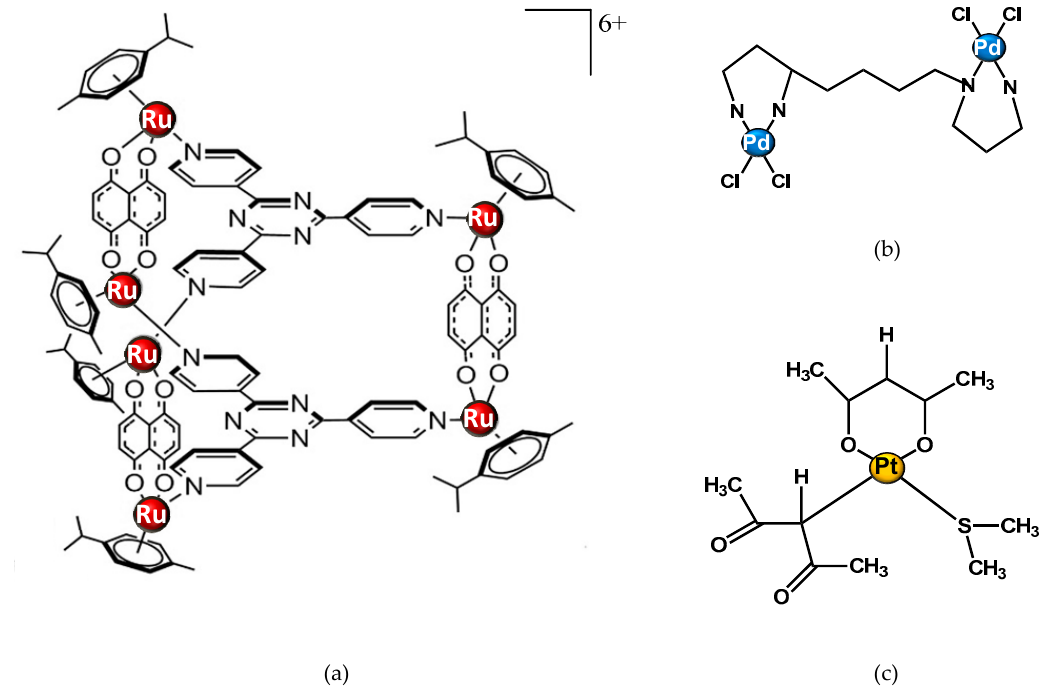
Figure 4. Structure of metal complexes different from cisplatin and studied through 1 H NMR metabolomic approaches. ( a ) Ruthenium metallaprism; ( b ) Pd 2 spermine; ( c ) [Pt( O , O ’-acac)( γ - acac)(DMS)], Ptac2S.